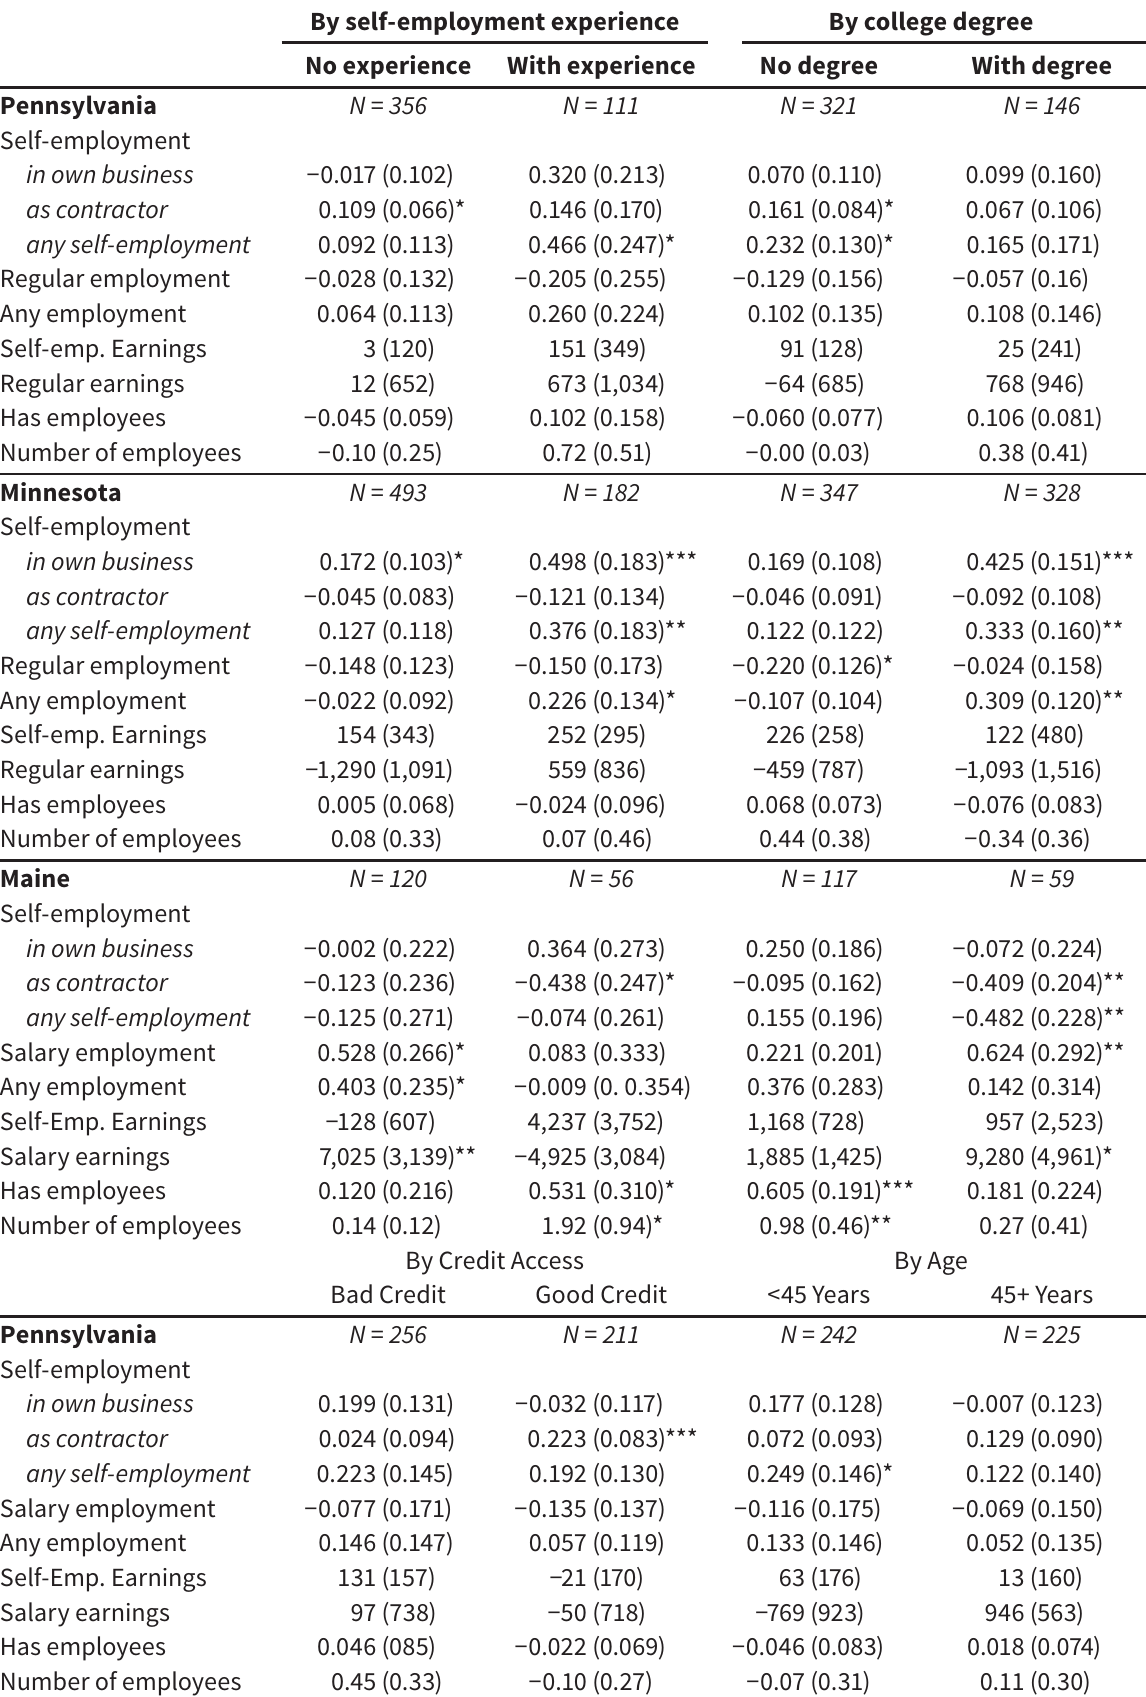
Table 5 Local average treatment effects by selected characteristics, Project GATE By self-employment experience By college